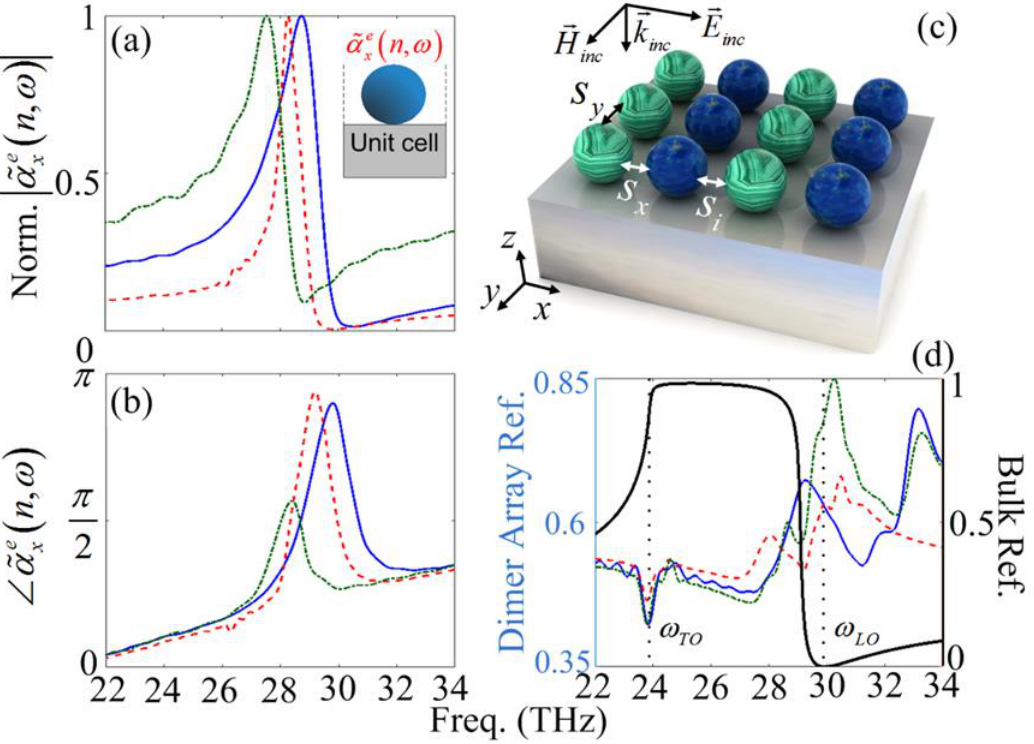
Figure 4. ( a , b ) The normalized amplitude and phase of the e ff ective susceptibility of a substrate induced doped SiC nanoparticles for n = 10 18 (solid curve), n = 2 × 10 19 (dashed curve) and n = 4 × 10 19 ( cm − 3 ) (dashed-dotted curve), respectively. ( c ) Schematic representation of the square patterned metasurface composed of SiC nano-spheres dimers with di ff erent doping values. ( d ) The reflection spectrum of the dimer arrays for n 1 = 10 18 and n 2 = 2 × 10 19 (solid curve), n 1 = 10 18 and n 2 = 4 × 10 19 [dashed-curve], n 1 = 2 × 10 19 ( cm − 3 ) and n 2 = 4 × 10 19 ( cm − 3 ) [dashed-dotted-curve], respectively, with s = 200 nm.